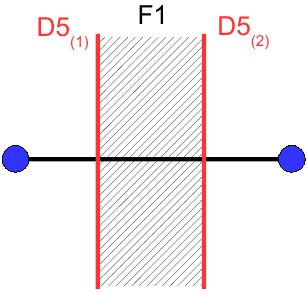
Figure 9 . Setup for the operator (cid:0) Z 2 1 Z 1 2 or equivalently (cid:0) Z 1 1 Z 2 2